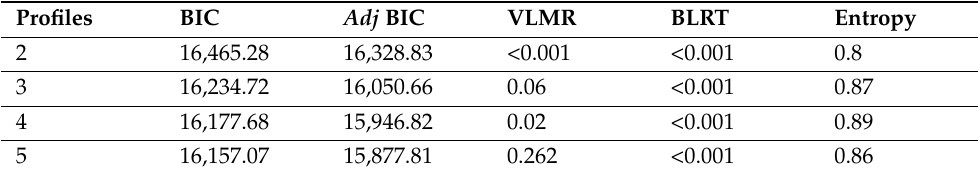
Table 2. Model fit indices for solutions for Profiles 2–5 poultry farmers.